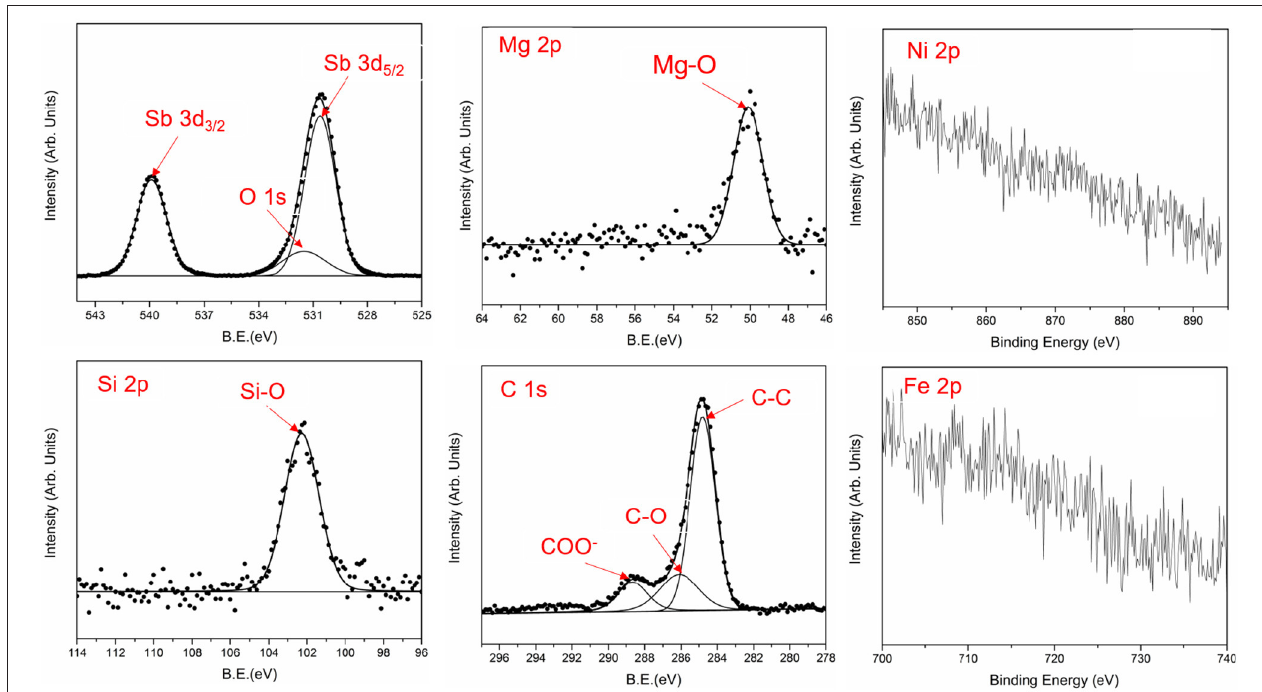
FIGURE 11 | XPS spectra of the elements on the wear track area of Sb 2 O 3 -MSH/C under 300 ◦ C (point A in Figure 6 ).